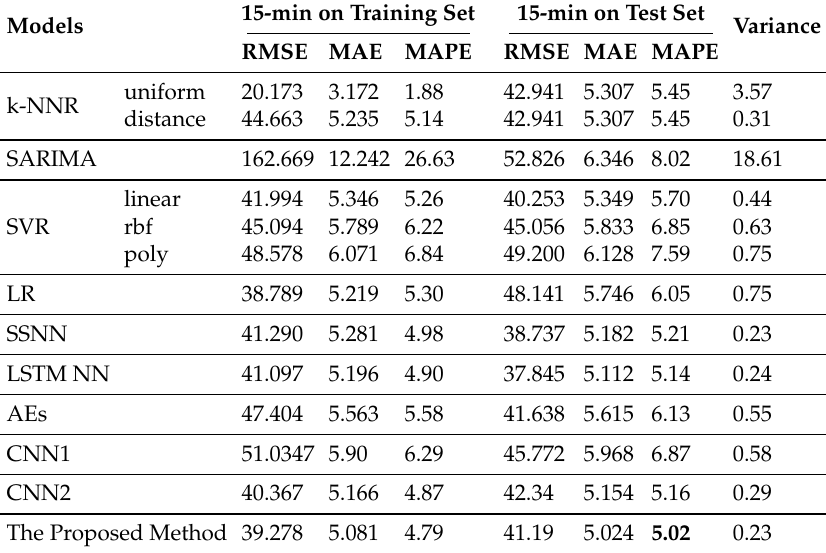
Table 5. Experimental results of the proposed method and the baseline methods on link AL281. The best results in the table appear in